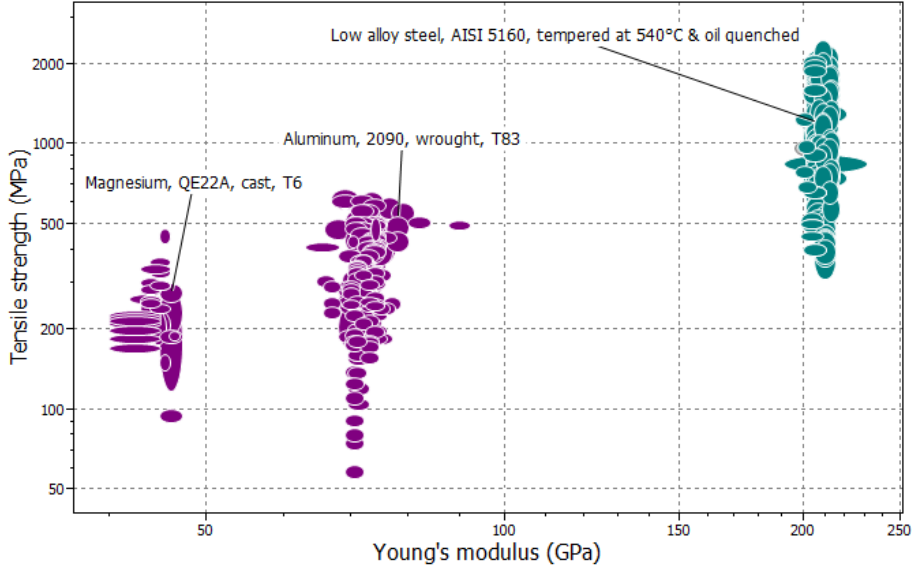
Figure 1. Visualization of relevant datasets from big data of engineering materials.